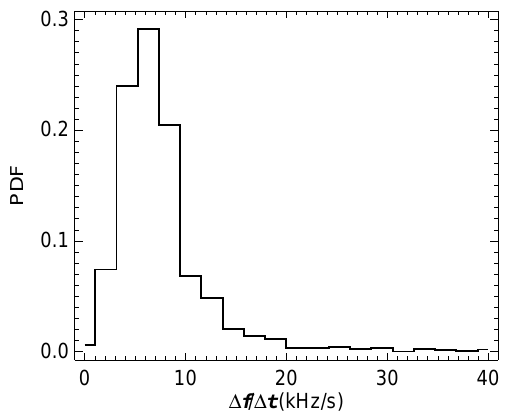
Fig. 2. Lower frequencies f 1 (red points) and upper frequencies f 2 (blue points) of each analyzed chorus wave packet normalized to local electron cyclotron frequency f ce as a function of the Z S M coordinate for the 4682 analyzed wave packets recorded by the four Cluster spacecraft in the chorus source region.